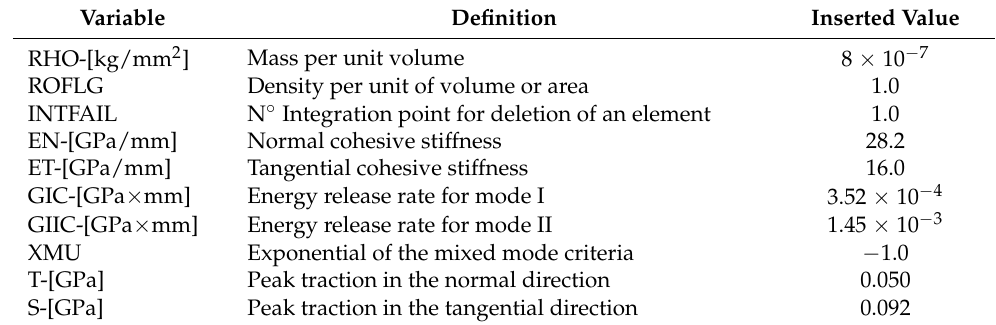
Table 6. MAT138 material parameters for the interlaminar region.